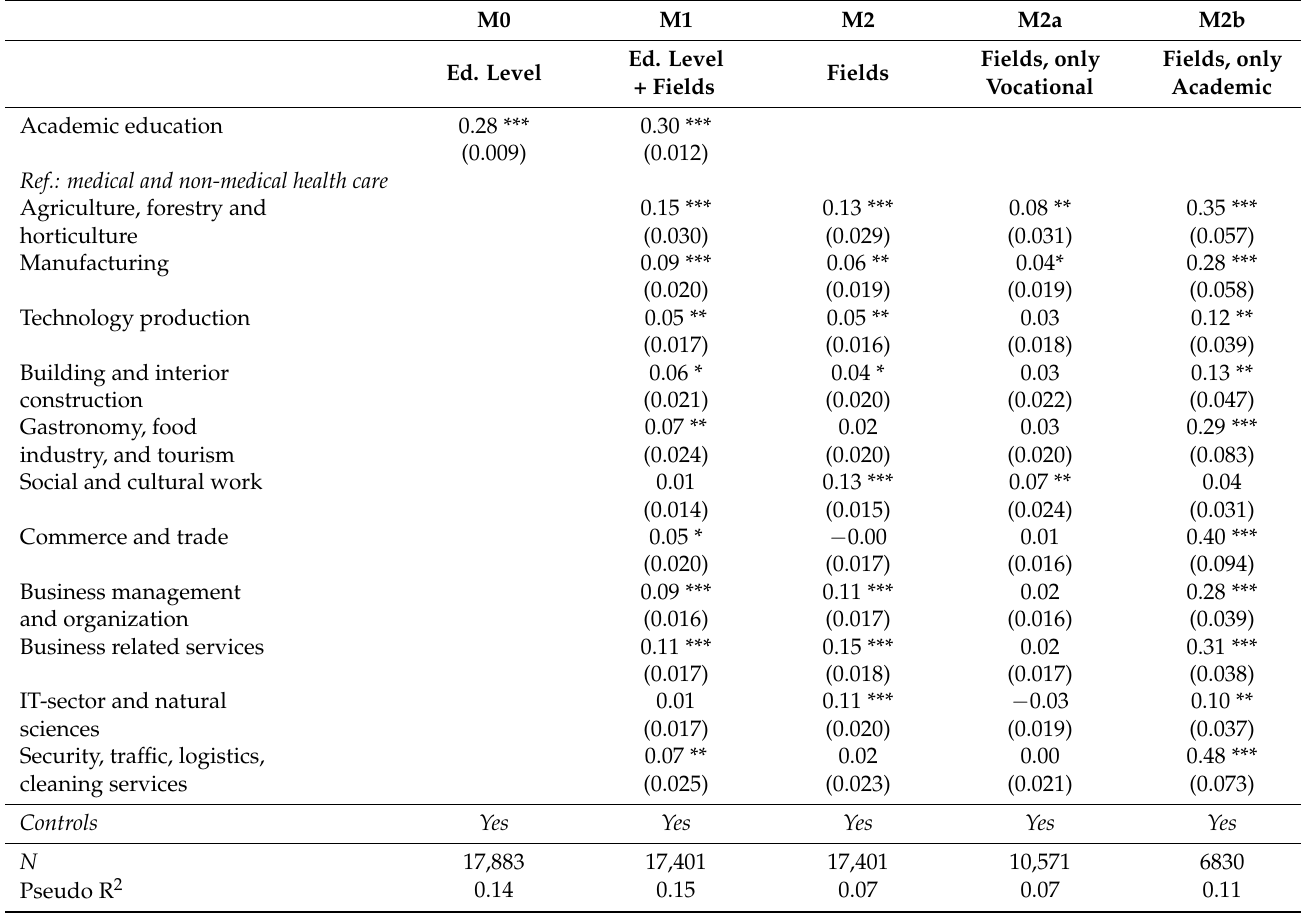
Table A1. Logit regression models of overeducation (objective indicator) on educational level and educational fields (AME) 1 . M0